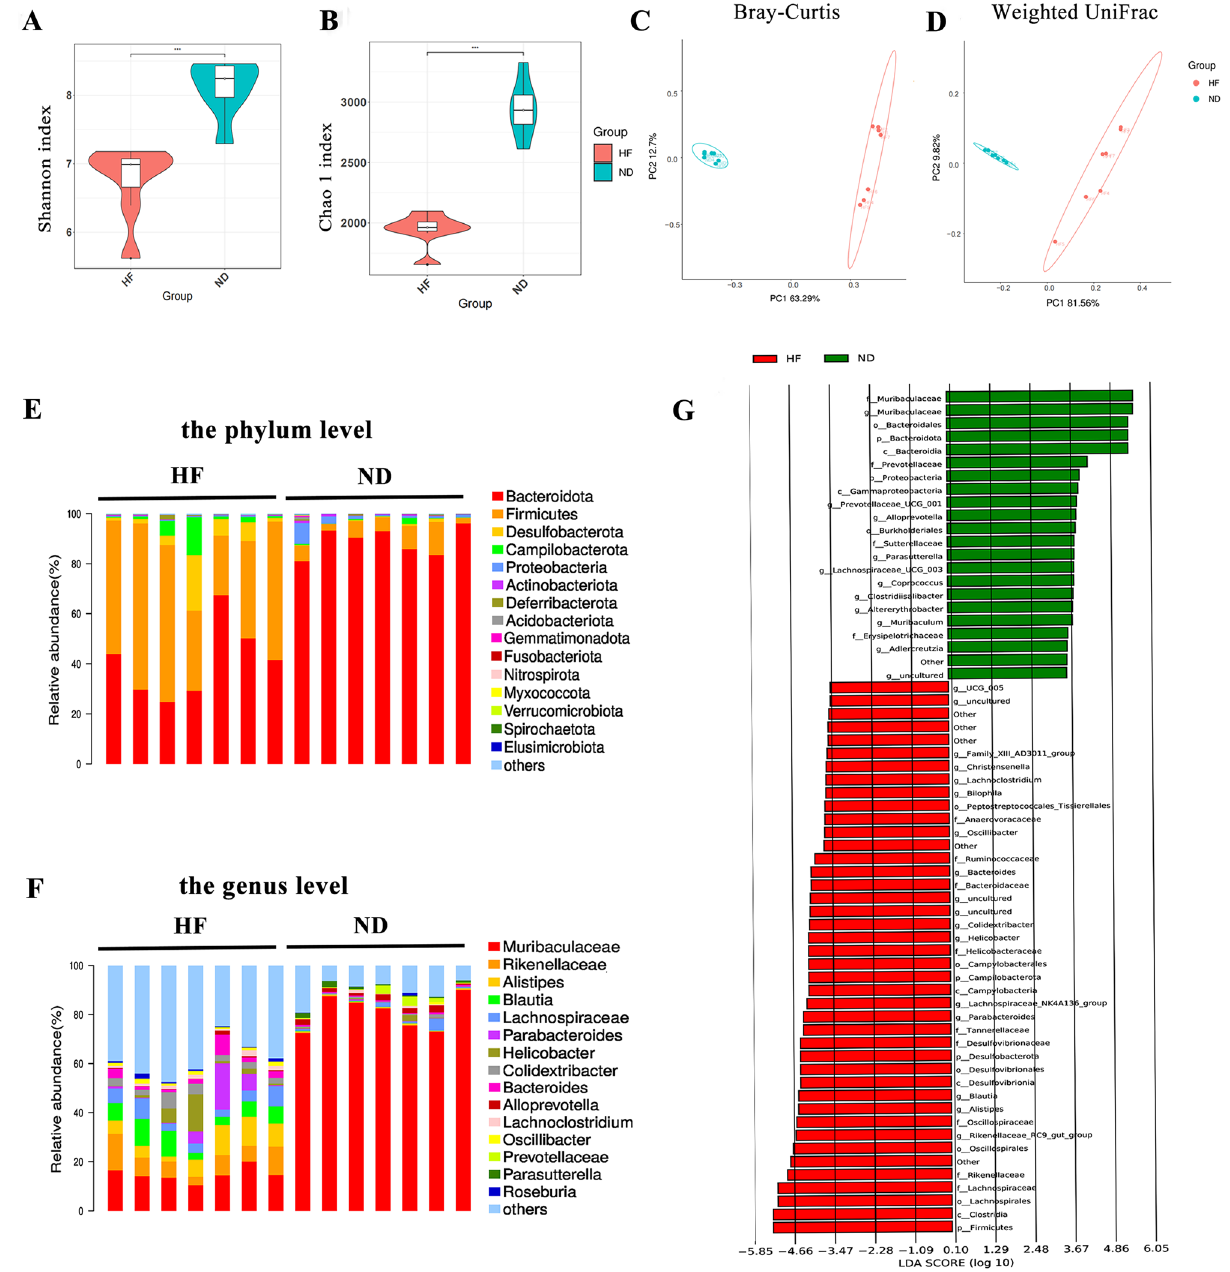
Figure 4. Analysis of the gut microbial community by 16S rRNA pyrosequencing from feces of HF and ND groups after feeding for 4 weeks. α-Diversity was calculated by Shannon index ( A ) and Chao 1 index ( B ). Principal coordinate analysis of ( C ) unweighted UniFrac analysis and ( D ) Bray–Curtis analysis. ( E , F ) Relative abundances of a common set of microbial families were compared at the phyla and genus level in HF and ND groups. ( G ) Differences in microbial taxa at all taxonomic levels between HF and ND group were calculated by LDA effect size (LEfSe). Mann–Whitney test was used to determine statistical significance. * p < 0.05; ** p < 0.01; *** p <